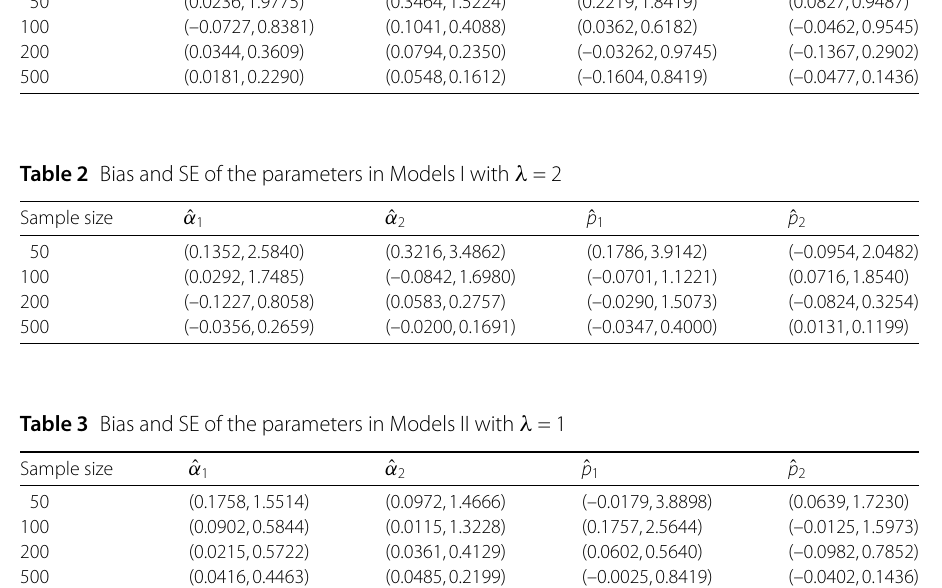
Table 1 Bias and SE of the parameters in Models I with λ = 1 Sample size